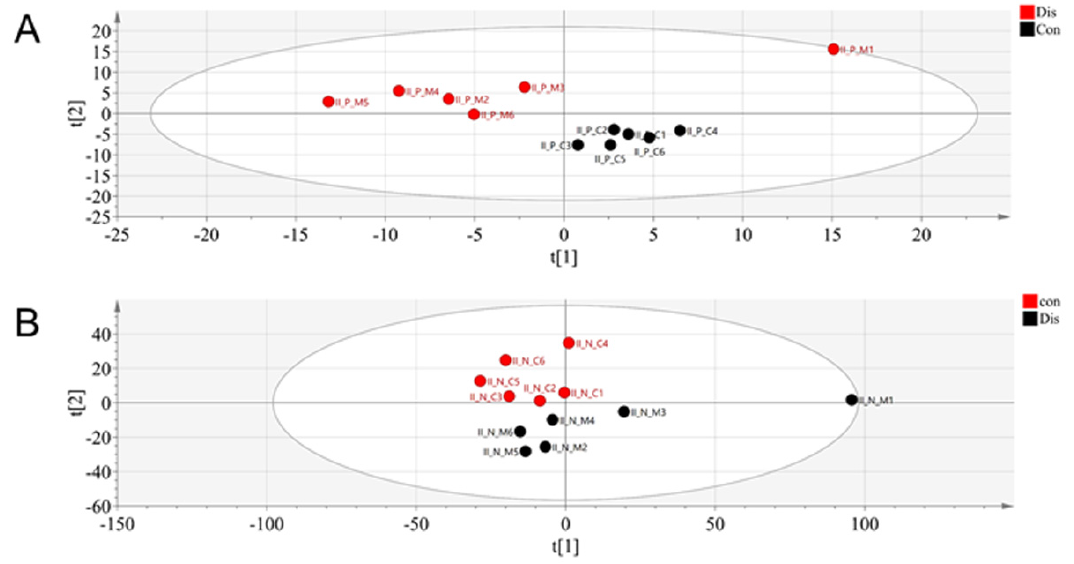
Figure 2. PCA analysis of OA group and control group: ( A ) in positive ion mode and ( B ) in negative ion mode.